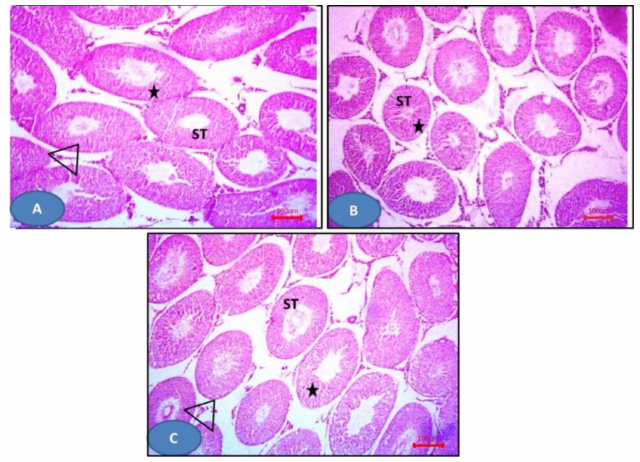
Figure 11. Photomicrographs of sections of the testis: ( A – C ) 6a – c respectively showing more or less normal seminiferous tubules (ST) with germinal epithelium (stars) and Leydig cells (triangles). H&E ×